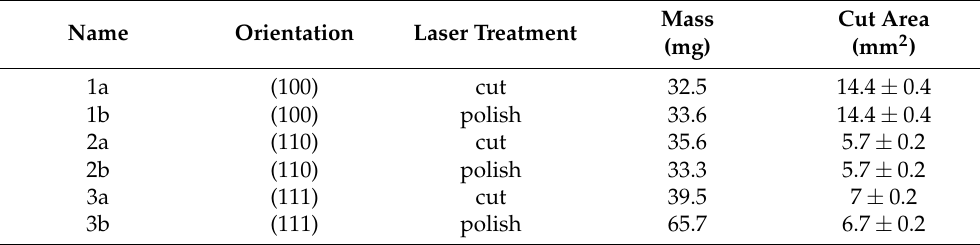
Table 2. Sample name, surface orientation, laser treatment, mass and cut area of the CVD dia- mond